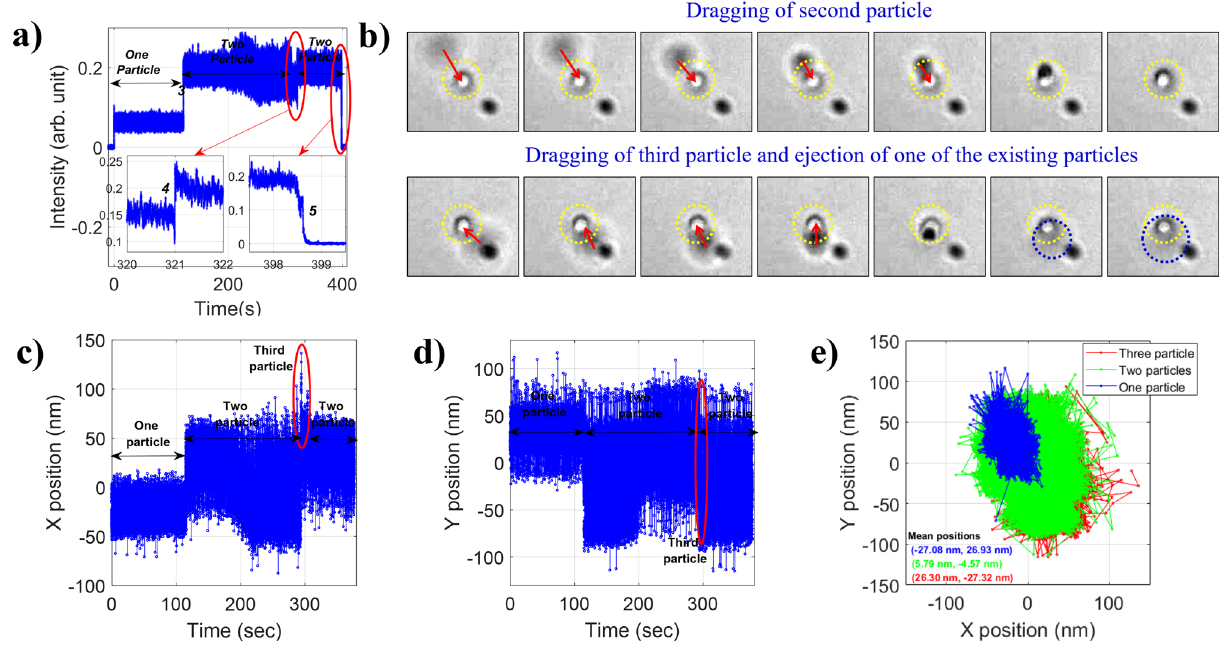
Figure 4. ( a ) Back-scatter signal for multiple (more than two) particles, ( b ) transmitted wide-field microscopy images of the particles to map dragging of second and third particle when first and among one of two particles is residing inside the nonlinear optical trap respectively. Position along ( c ) x-axis, ( d ) y-axis against time, and ( e ) x–y trajectory. The data are for confinement of multiple particle within the nonlinear optical trap at 14.10 mW average power under pulsed